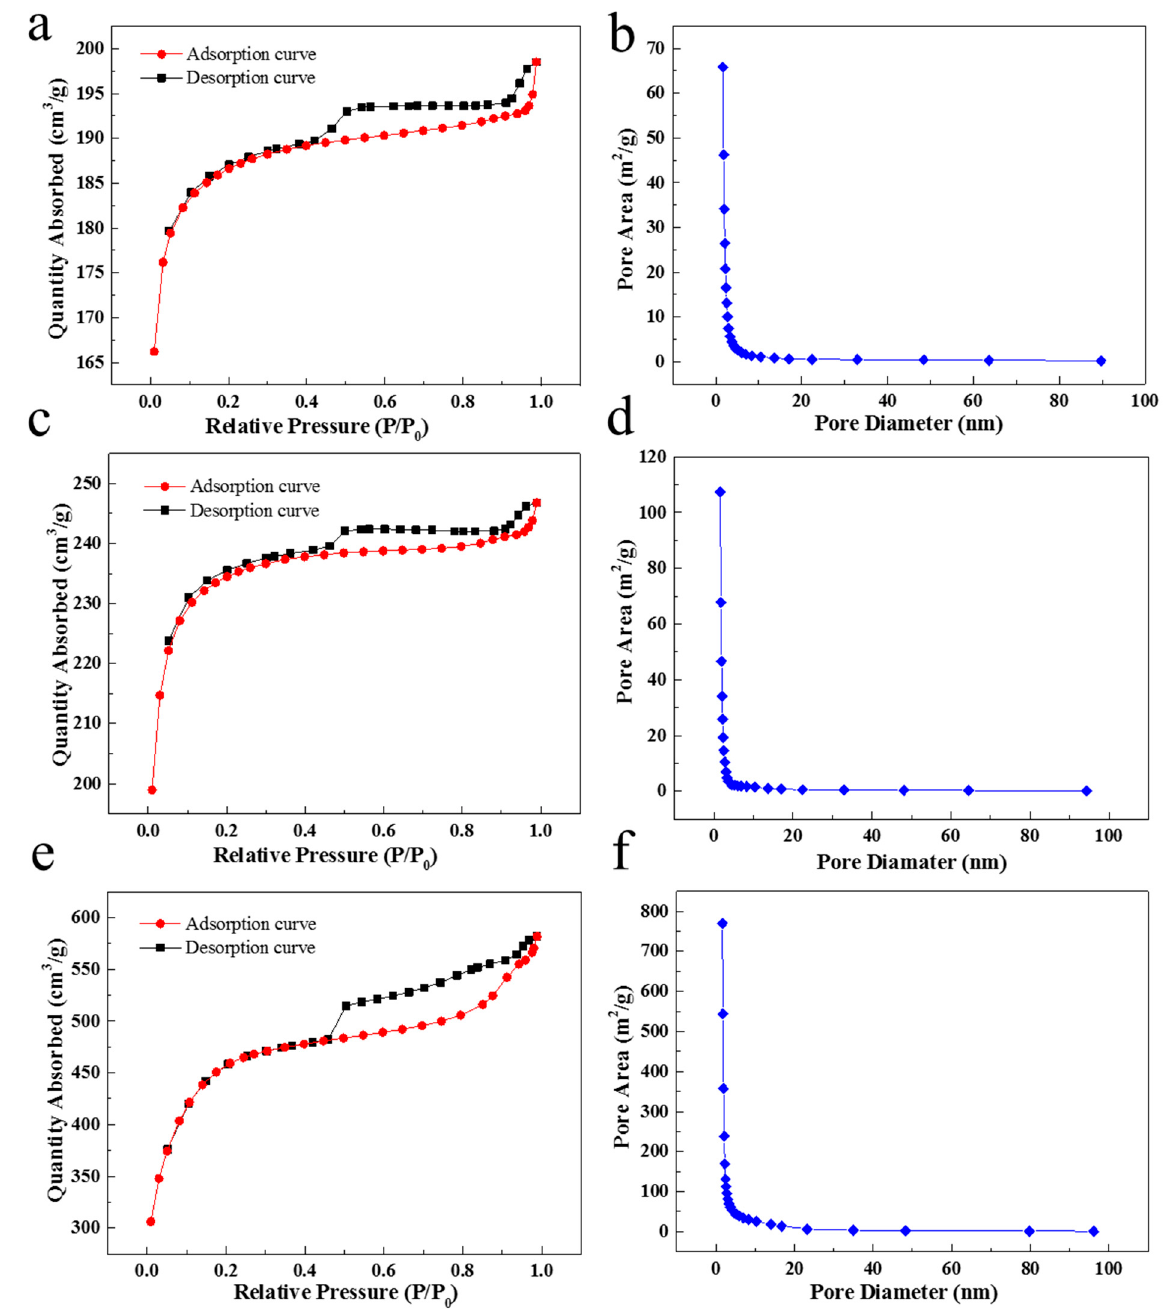
Figure 4. N 2 adsorption–desorption isotherms and the pore size distributions of samples ( a , b ) SC850, ( c , d ) SC950 and ( e , f ) SC1050. Table 3. Microstructural information of samples SC850, SC950 and SC1050.